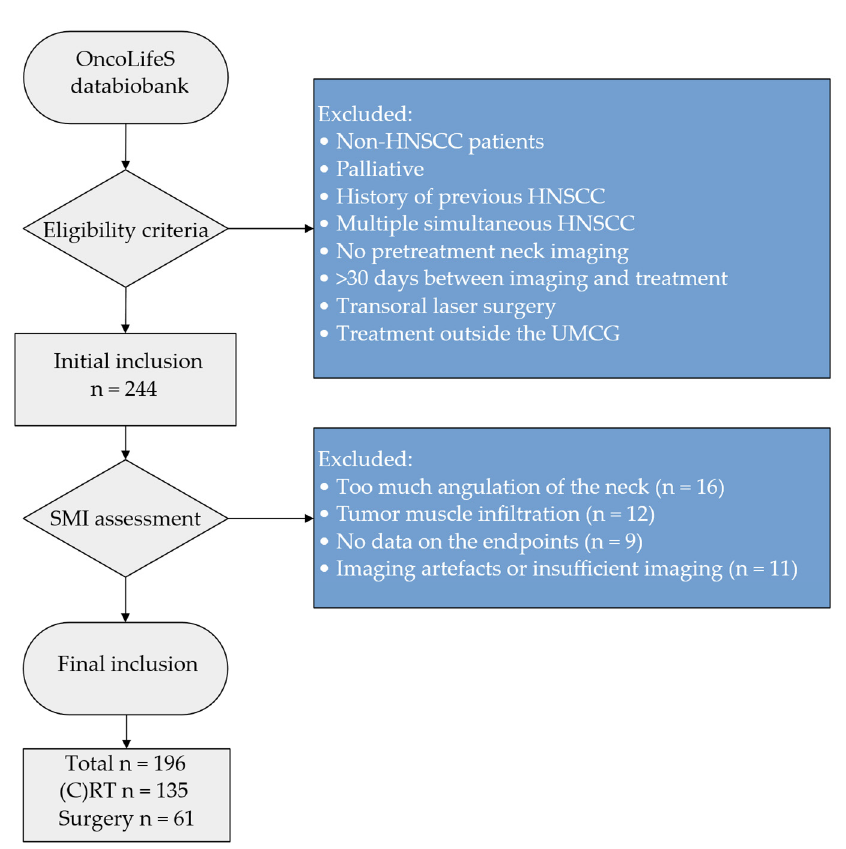
Figure 1. Flowchart of in- and excluded patients. Abbreviations: HNSCC = head and neck squamous cell carcinoma, (C)RT = (Chemo-)Radiotherapy, SMI = skeletal muscle index, UMCG = University Medical Center Groningen.